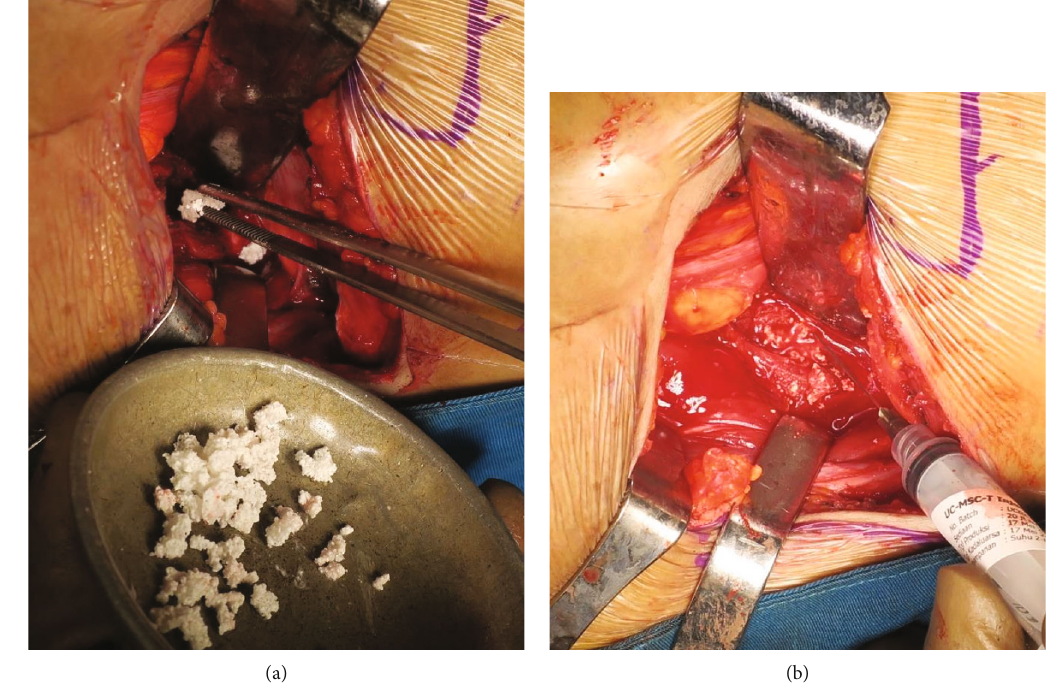
Figure 3: UC-MSCs and hydroxyapatite-based sca ff old application on the vertebral bone defect